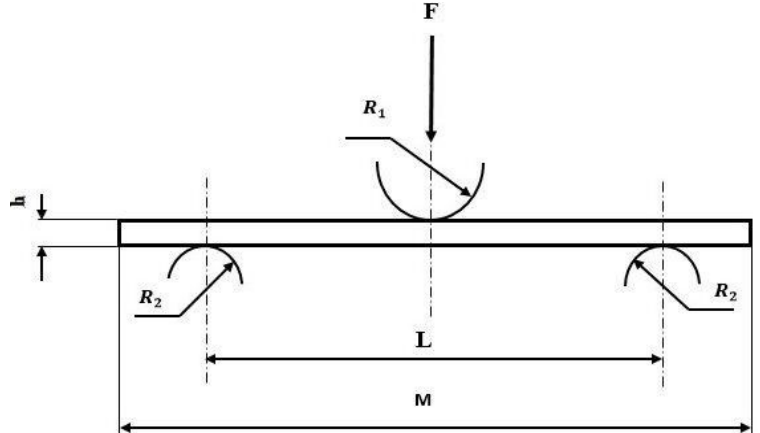
Figure 2. Load configuration for a beam in three-point bending